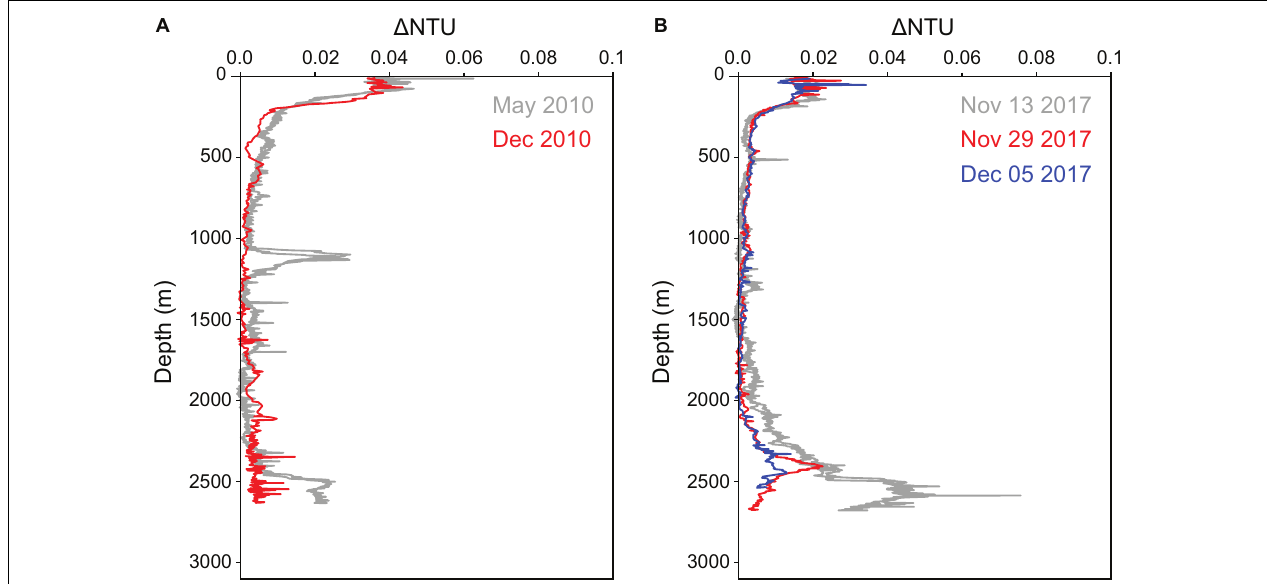
FIGURE 8 | Short-term variability of deep plume turbidity over time: (A) May 2010 compared to December 2010; (B) repeat profiles over 25 days in November/ December 2017.